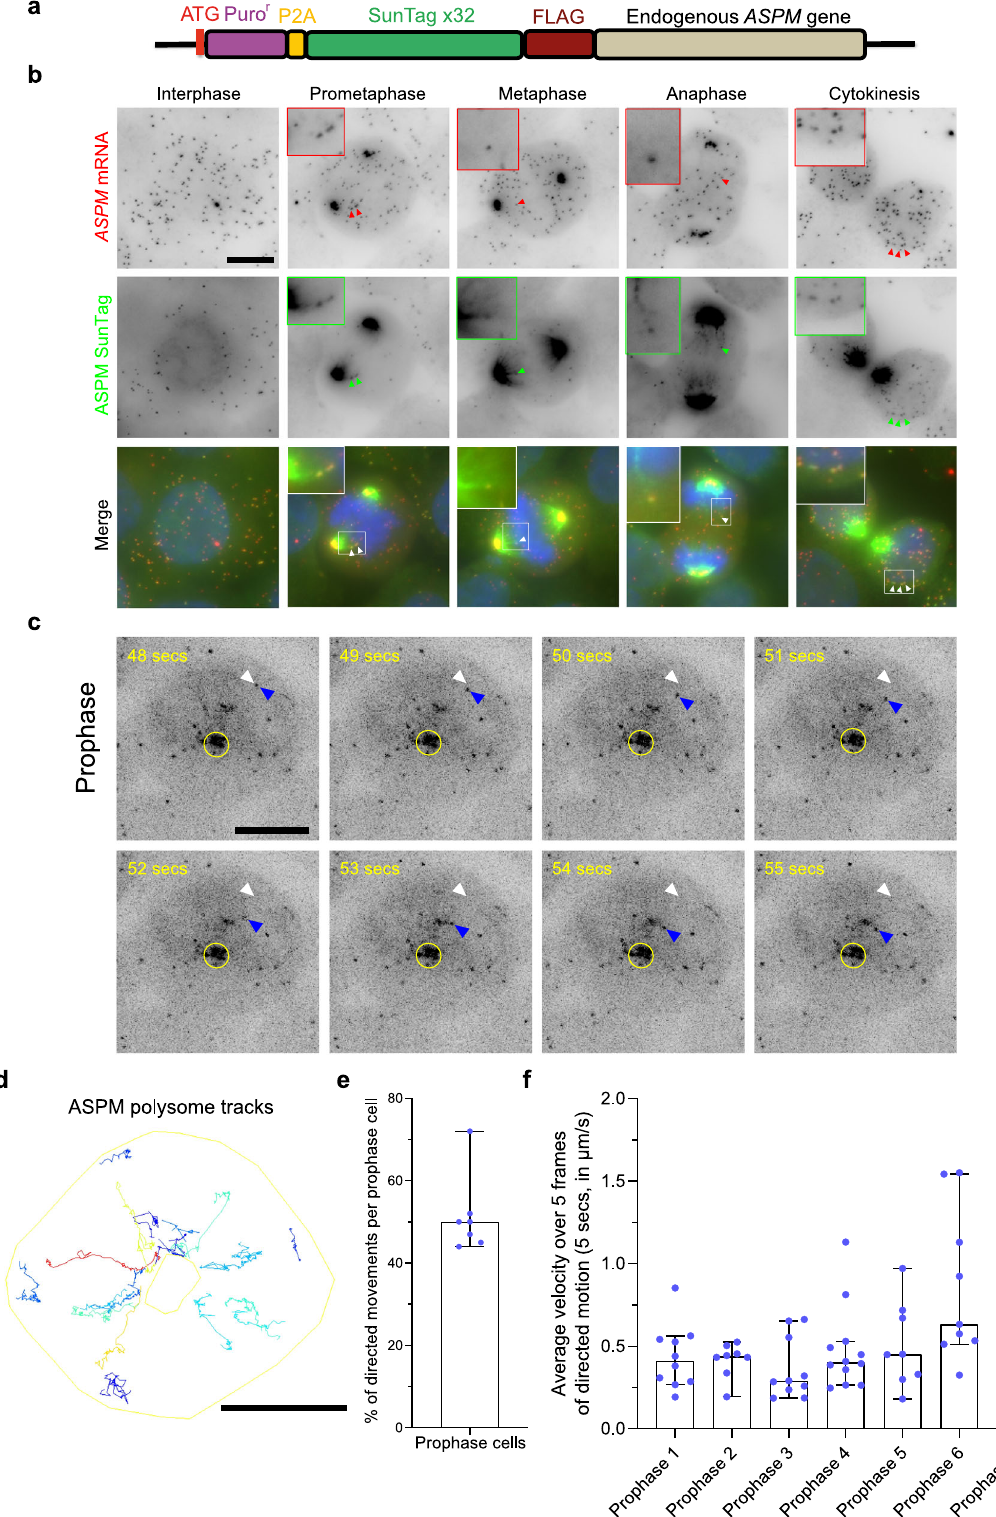
NUMA1 clone, smiFISH against the endogenous NUMA1 mRNA revealed that the mRNA colocalized with bright SunTag foci in both interphase and mitosis (Fig. 8b; Supplementary Fig. 11d). A puromycin treatment removed these bright cytoplasmic SunTag foci, con fi rming that they were NUMA1 polysomes (Supple- mentary Fig. 11e). Therefore, tagging the endogenous